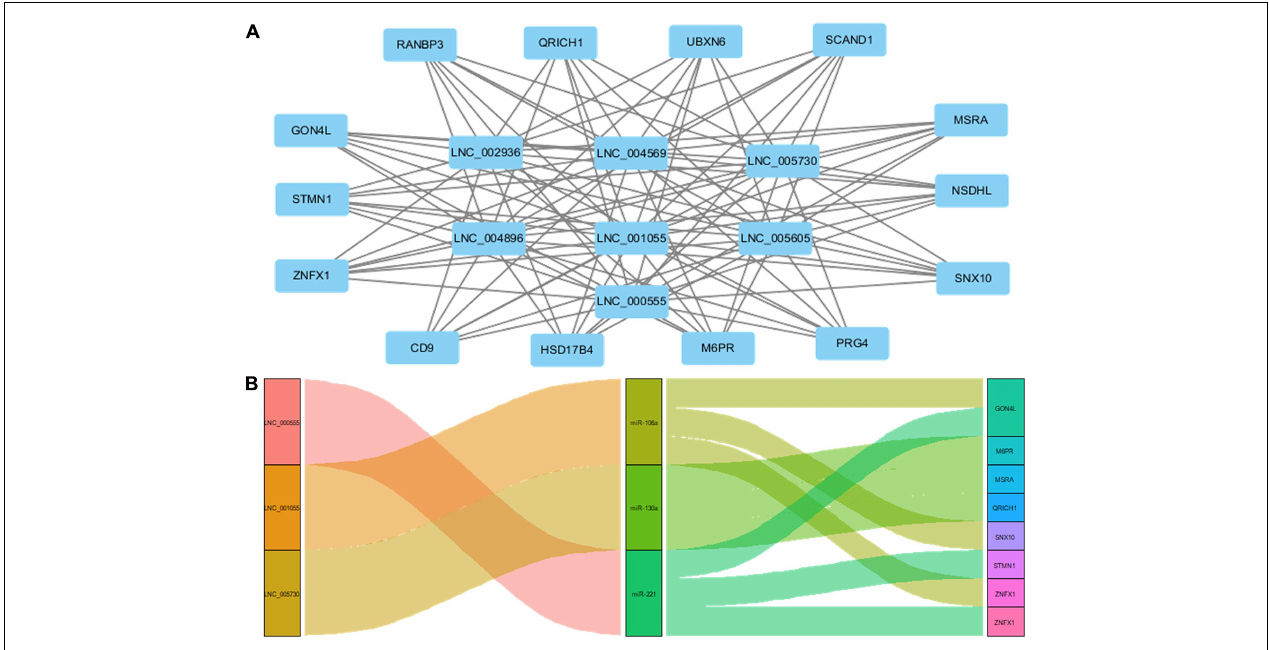
FIGURE 5 | Target genes of lncRNAs and ceRNA interaction model. (A) The network of coexpressed target genes of lncRNAs. (B) The network of lncRNA–miRNA–mRNA interaction model.